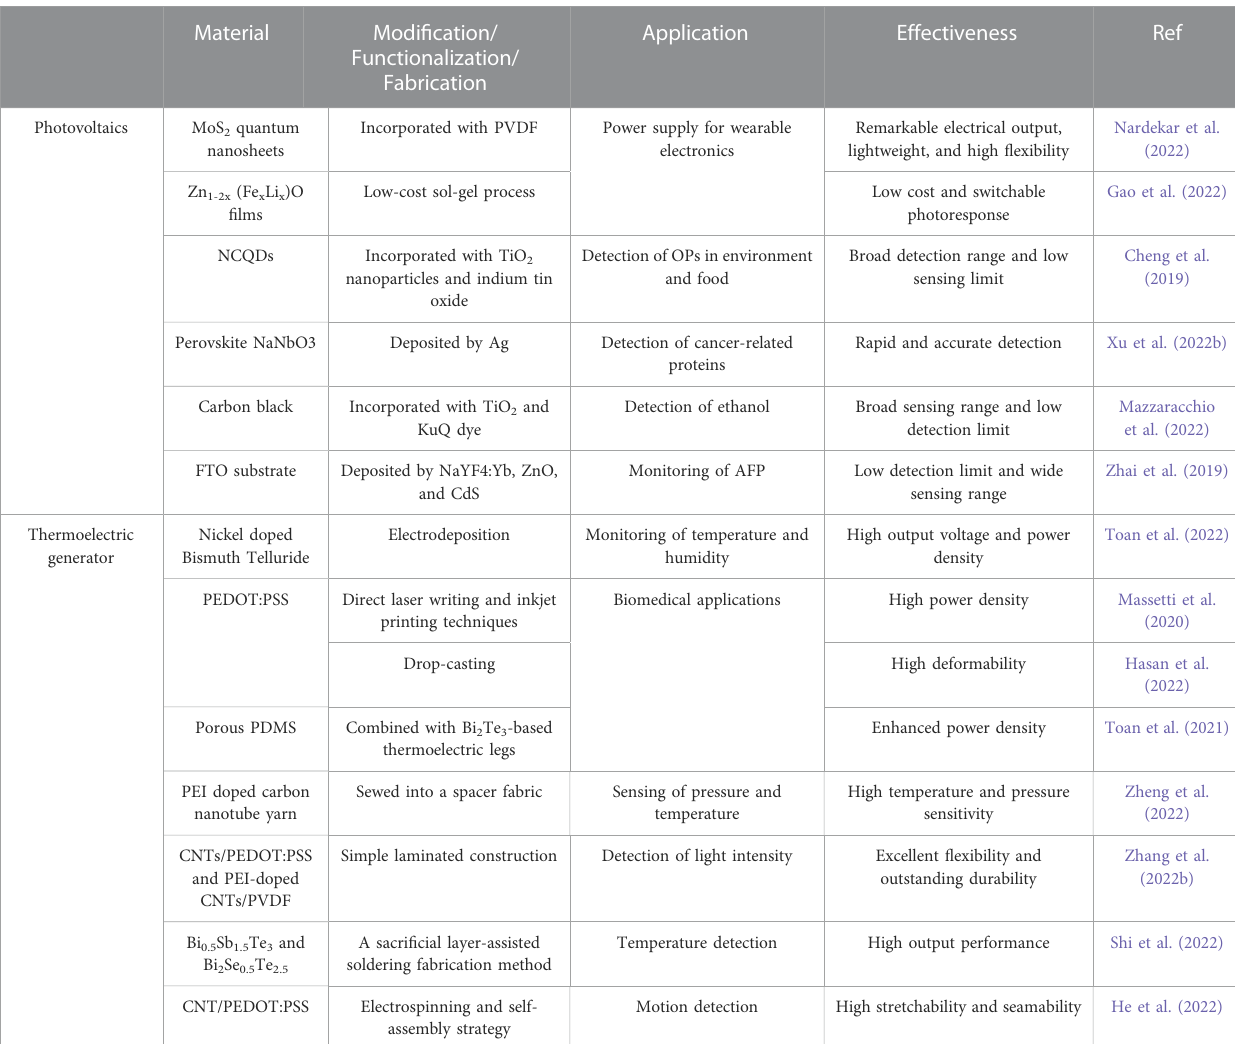
TABLE 1 ( Continued ) Examples of self-powered technology towards wearable biosensors and biomedical applications. P(VDF-TrFe): poly (vinylidene fl uoride-co- tri fl uoroethylene); CNTs: carbon nanotubes; PVDF: polyvinylidene fl uoride; PT: polythiophene; MAPbBr 3 : Methylammonium lead tribromide; BTO: barium titanate; EGain: eutectic gallium-indium; Co-NPC: cobalt-based nanoporous carbon; PANI: polyaniline; NPCO: nanoporous cobalt oxide; PVA/PA: polyvinyl alcohol/phytic acid; TSCH: transparent, stretchable and conductive hydrogel; FEP: fl uorinated ethylene propylene; CNTs: carbon nanotubes; rGO: